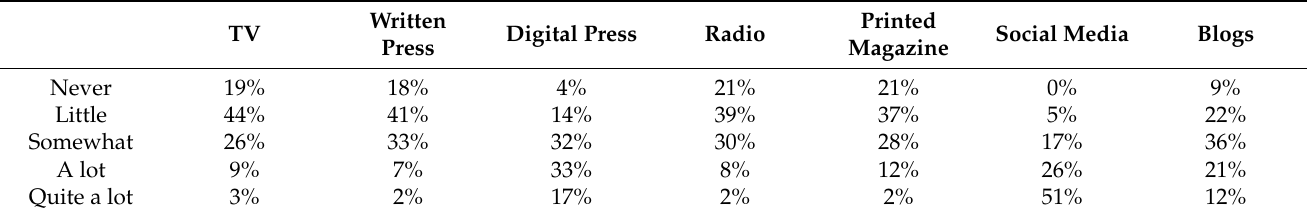
Table 3. Media consumption of university students from Nuevo Le ó n, Valle de M é xico and Oaxaca.